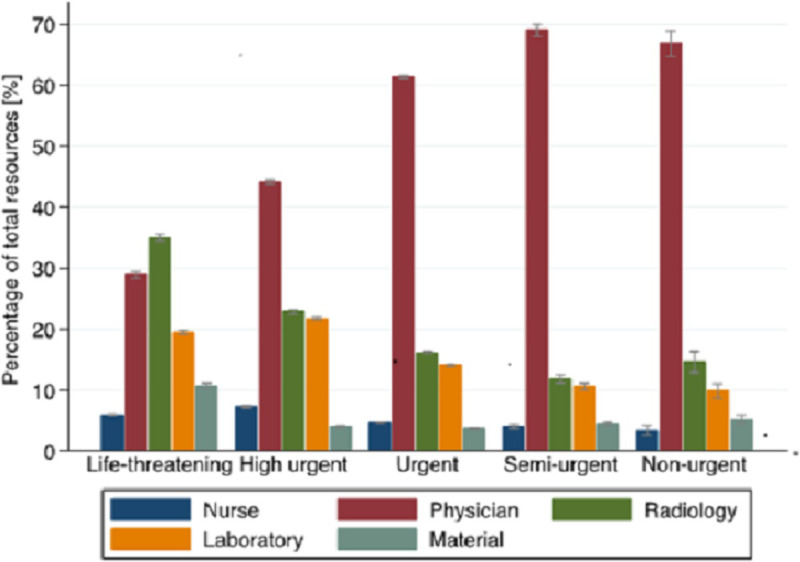
Comparison of the distribution of the total ED resource consumption (mean percentage of total resources and 95% CI bars) by triage category (n = 82,388*).*the triage category was missing in 1,148 consultations.